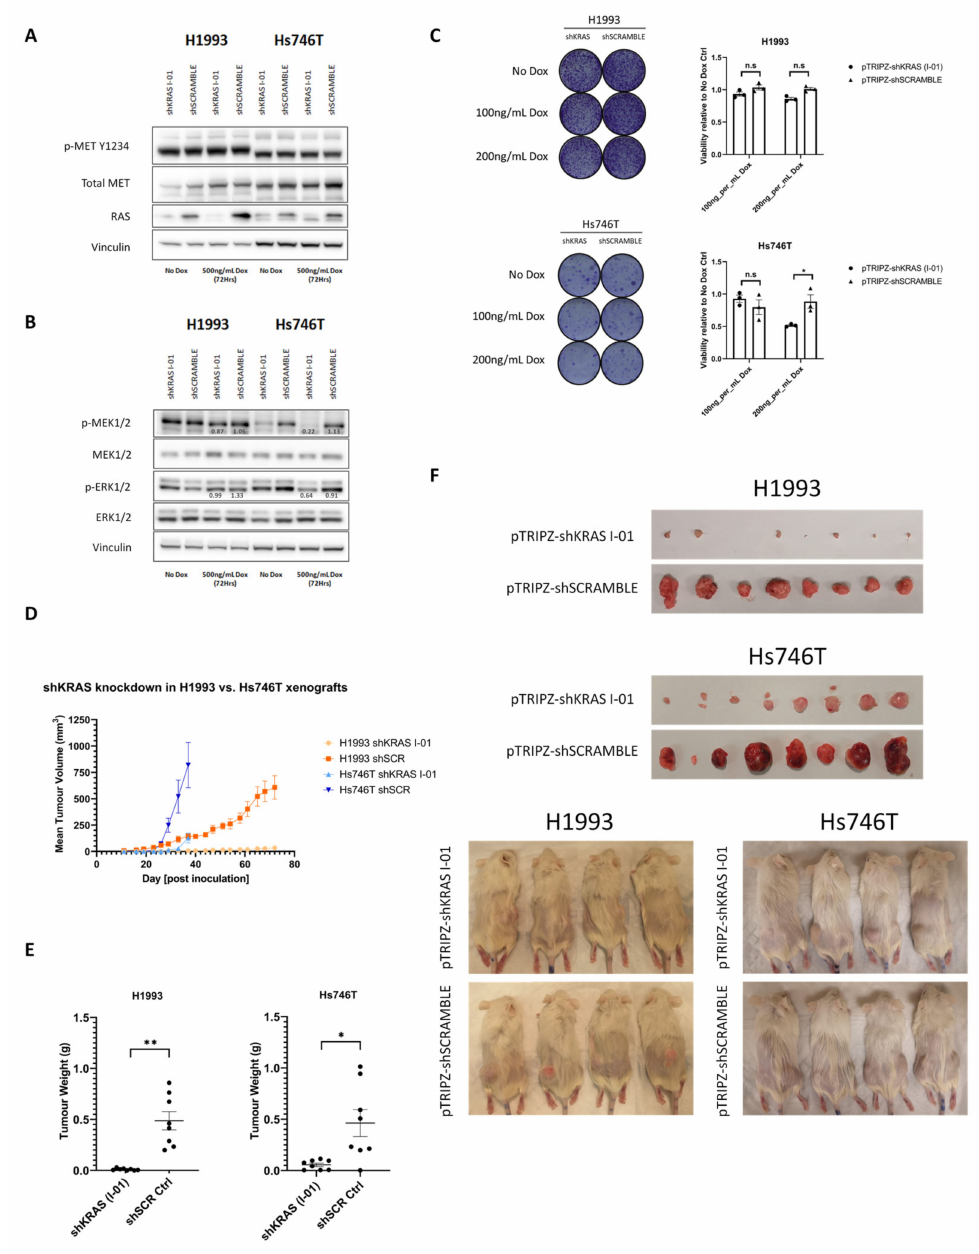
Figure 4. MET-driven cell growth is dependent on activation of the Ras/MAPK pathway. ( A ) Western blot analysis depicting partial or total loss of Ras protein in H1993 and Hs746T carcinoma cells following doxycycline treatment (500 ng/mL Dox for 72 h) . ( B ) Western blot analysis showing the effect of KRAS knockdown on the phosphorylation of downstream effectors MEK1/2 and ERK1/2. ( C ) Viability assay by 6-well clonogenics demonstrating a negative impact of KRAS loss on cell viability in MET ∆ ex14 -expressing Hs746T cells compared to MET WT-expressing H1993 cells in vitro, as measured by Alamar Blue and Crystal Violet staining. ( D ) Tumour growth kinetics at endpoint of H1993 (shKRAS: n = 8; shSCR: n = 8) and Hs746T (shKRAS: n = 8; shSCR: n = 8) cells injected subcutaneously into flanks of NRG mice maintained on doxycycline diet (starting 4 days before injection) demonstrate that loss of KRAS hinders tumour growth in vivo in both MET-addicted cell lines. ( E ) Tumour weights at endpoint correlate with our results in ( D ), demonstrating that loss of KRAS hinders tumour growth in vivo in both cell lines. ( F ) Visual comparison of H1993 vs. Hs746T xenograft tumours with or without KRAS knockdown. n.s, not significant; * p < 0.05; ** p < 0.01 for the indicated